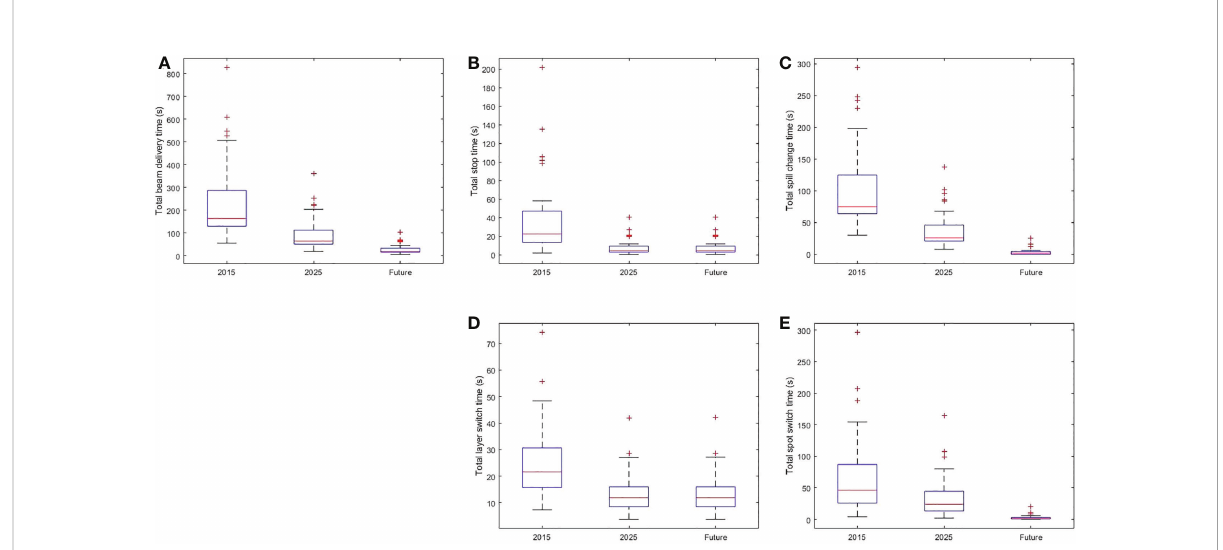
FIGURE 1 Box Plot of Beam Delivery Time and Time of Each BDT Component in the 2015, 2025, and Future Systems. (A) The distribution of total beam delivery time. (B) The distribution of the total stop time. (C) The distribution of the total spill change time. (D) The distribution of the total layer switch time. (E) The distribution of the spot switch time. Within each box, horizontal central line represents the median value and box represents the 25 th to 75 th